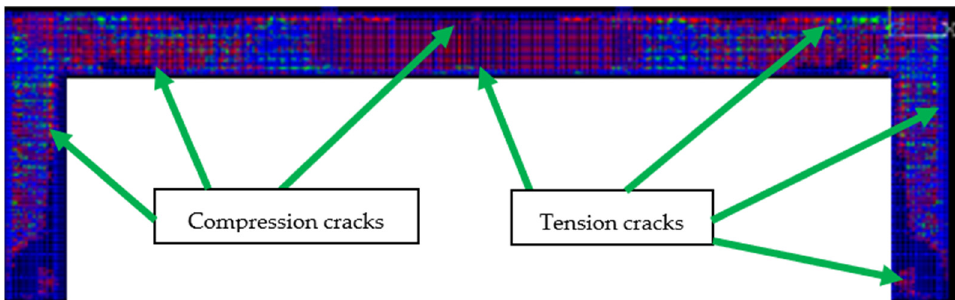
Figure 15. Cracks in sample F 0 at failure.